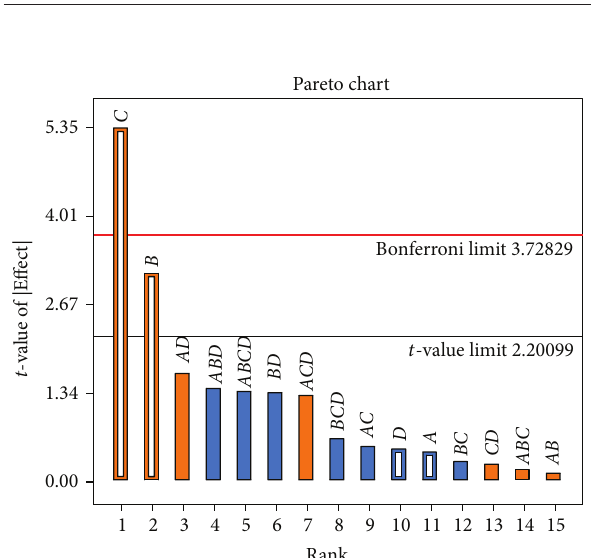
Figure 2: Pareto chart obtained after screening design. Variables: ( 𝐴 ) Sample-to-solvent ratio (1: 5 and 3 :5 w/v (mgmL −1 )); ( 𝐵 ) homogenization time (2 and 7min); ( 𝐶 ) use of ultrasound bath (0 and 5 min); and ( 𝐷 ) salting out effect (0 and 50 mgmL −1